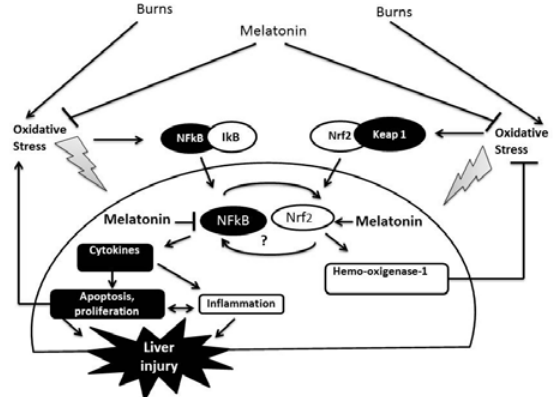
Figure 1. Possible mechanisms of burn-induced hepatic injury and melatonin protection. Thermal trauma can induce liver injury by activating NF- κ B-mediated pro-inflammatory pathway. Melatonin can considerably ameliorate burn-induced hepatic injury either by the induc- tion of Nrf2-mediated antioxidant response to attenuate oxidative stress and/or by suppressing NF- κ B-mediated inflammatory